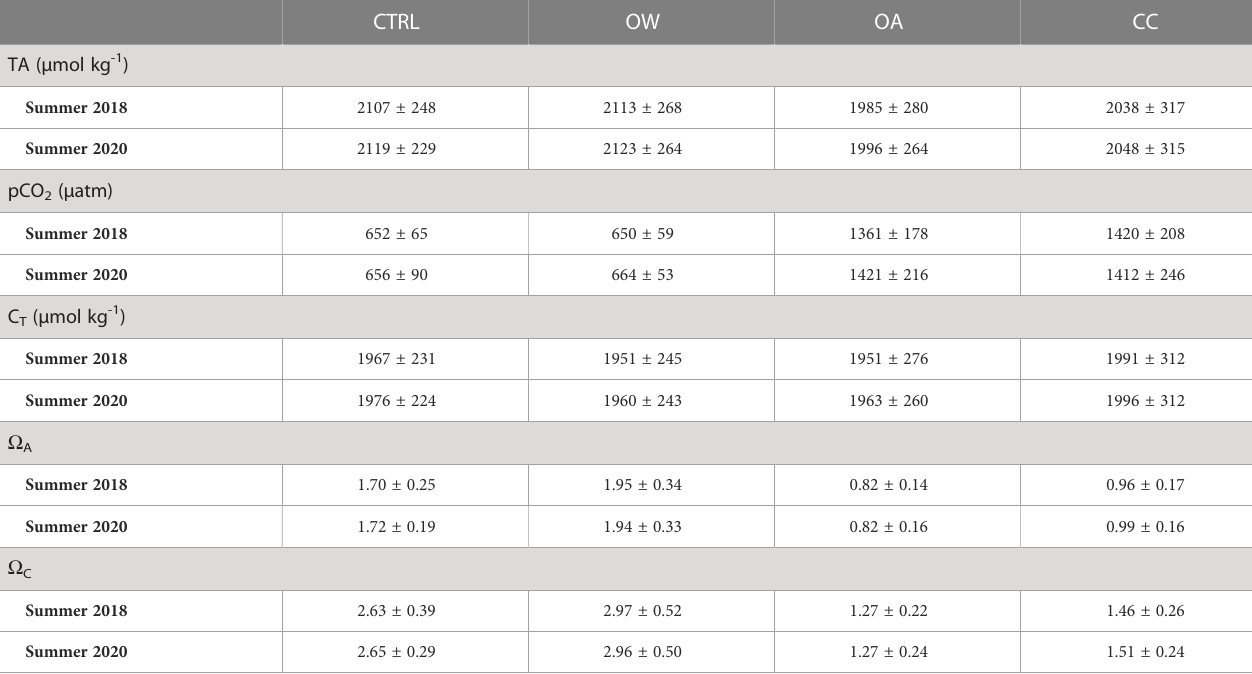
contribution of the shell bio fi lm decreased from 63% to 23% over the course of six weeks (Figure 2). Whole animals in CC produced on average 9.10 ± 1.82 nmol N 2 O ind -1 h -1 , while the associated shell bio fi lm contribution decreased from 60% to 12% over time, after an initial rise to 65% in the second week of experiments. Overall, temperature and pH had a signi fi cant, antagonistic effect on the parts of the animal that emitted N 2 O, with an increasing production in warmer environments and a decreasing production in acidi fi ed or combined climate change conditions (Table 4).